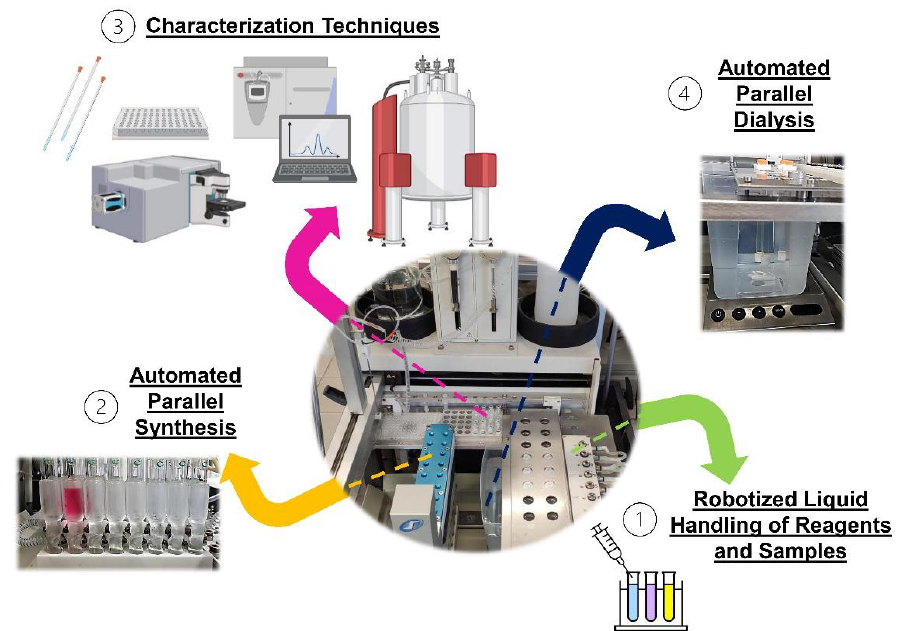
Figure 5. Schematic overview of the proposed APD method and its potential application in the synthesis and purification of polymer libraries utilizing commercially available APS.